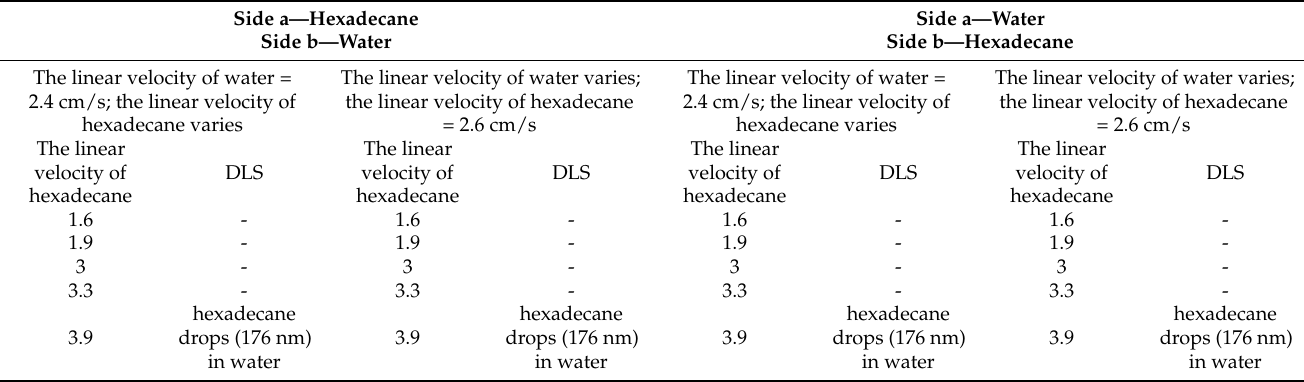
Table 6. Effect of operational parameters of the membrane contactor on the liquid–liquid interface stability for TEM-2. Side a—Hexadecane Side b—Water